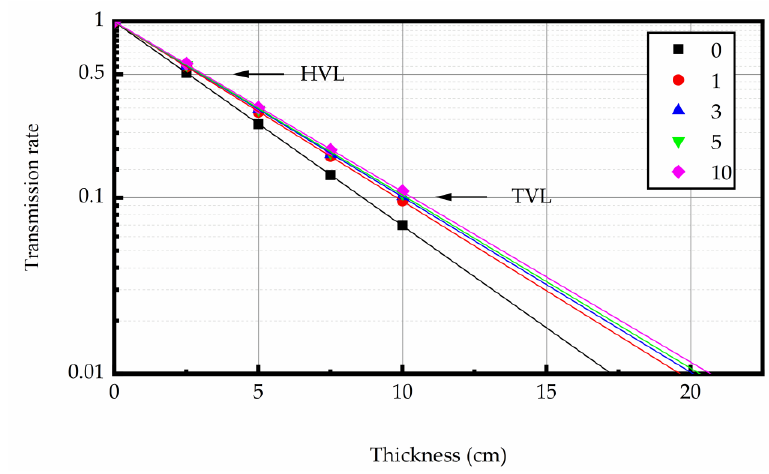
Figure 17. The relation between gamma-ray transmission rate and the concrete thickness at 400 °C.